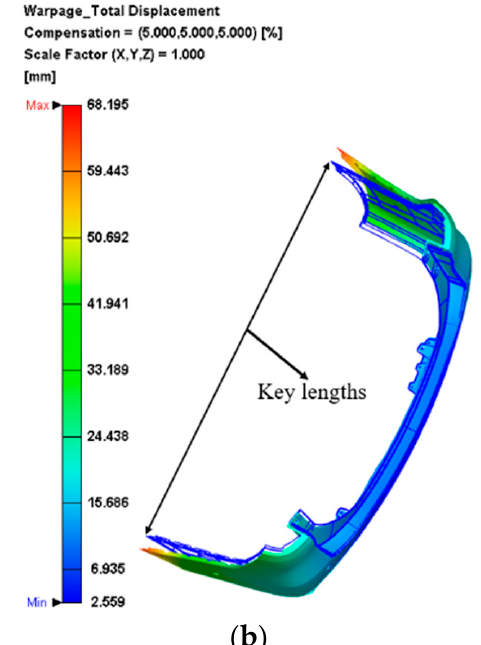
Figure 8. ( a ) The basic geometric dimensions of plastic bumpers; ( b ) warp key lengths for study.